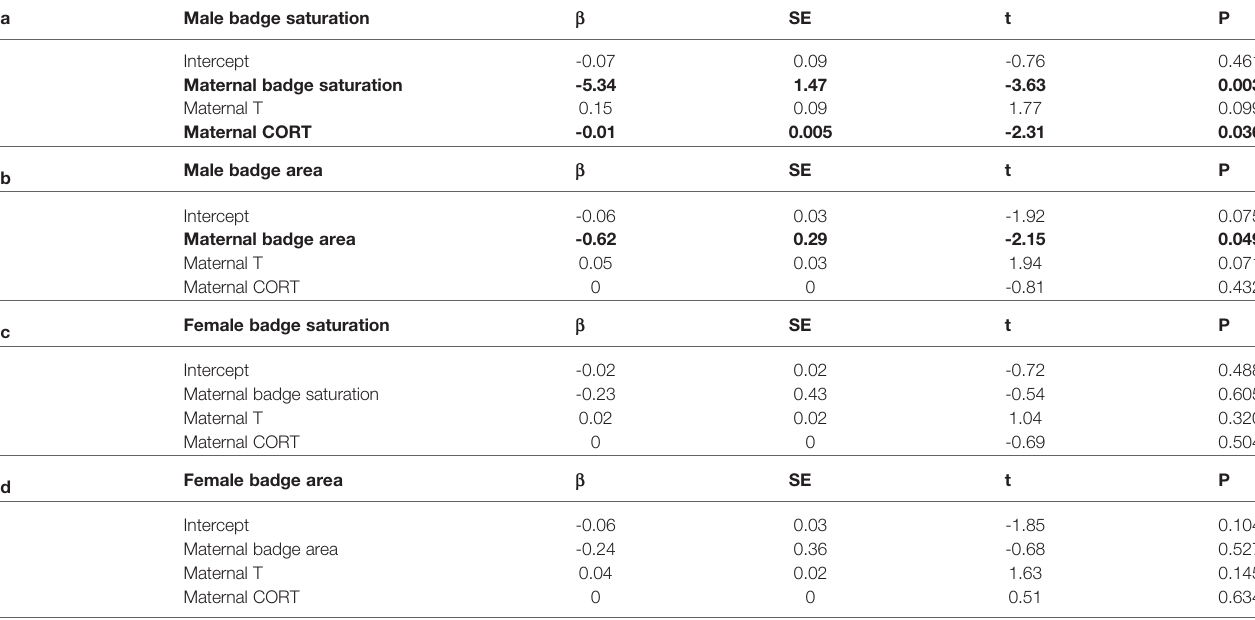
TABLE 2 | Output of four linear mixed-effects models for two measures of ornament quality (badge color saturation and badge area) in male and female offspring and their relationships with maternal phenotype and endocrine status during